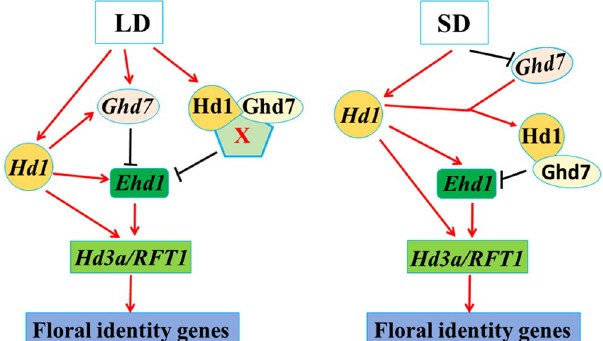
Figure 6. A model for the regulation of Ehd1 by Ghd7 and Hd1 . Hd1 alone promoted the expression of Ehd1 in LD and SD; Ghd7 , without Hd1 , repressed Ehd1 in LD; The interaction between Ghd7 and Hd1 was occurred, and repressed the expression of Ehd1 together with an unknown factor X in